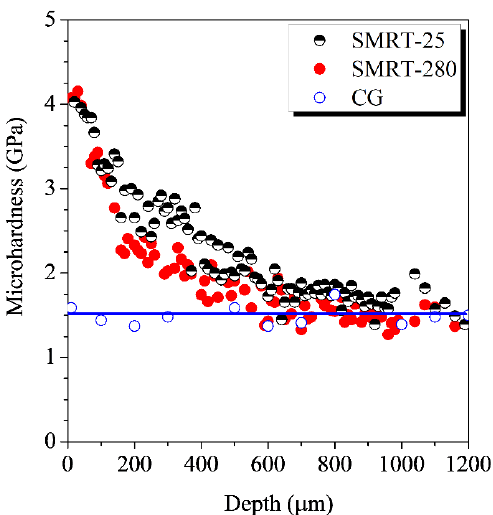
Figure 3. In-depth microhardness distributions in the SMRT-25 and the SMRT-280 samples, in comparison with that in the CG sample.